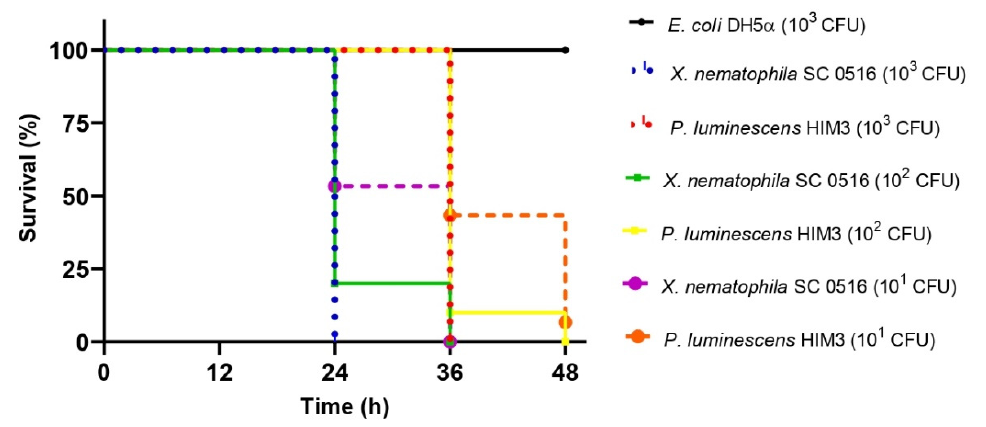
Figure 4. Kaplan–Meier survival curves of G. mellonella larvae after direct injection with X. nematophila SC 0516. Experiments were performed four times in independent bioassays, and survival was assessed at 12, 24, 36 and 48 h after infection. Differences in survival ( n = 60) were calculated using the log-rank test X 2 = 457.636, df = 6, p < 0.001. Table 1. Survival time (h) of G. mellonella larvae injected with different doses of colony forming units (CFUs) of X. nematophila SC 0516 and P. luminescens HIM3.